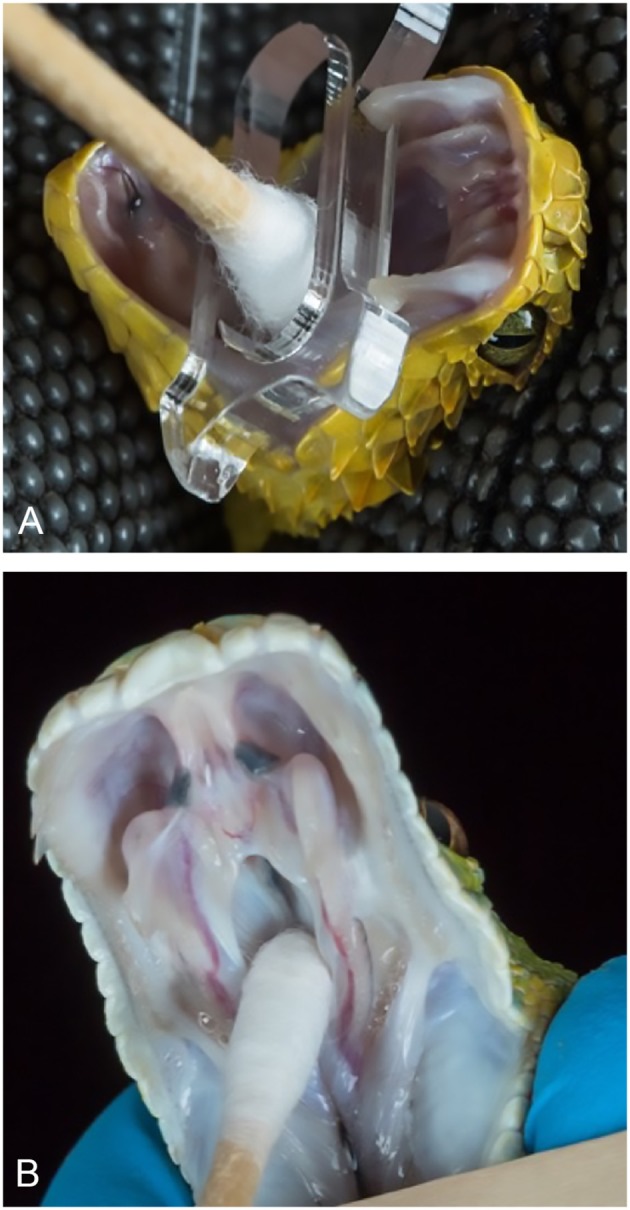
Oral (top) and choanal (bottom) swabbing of captive snakes. Variable bush viper (Atheris squamigera)
(A). Green tree python (Morelia viridis) (B). Photos courtesy of Greg Lepara.